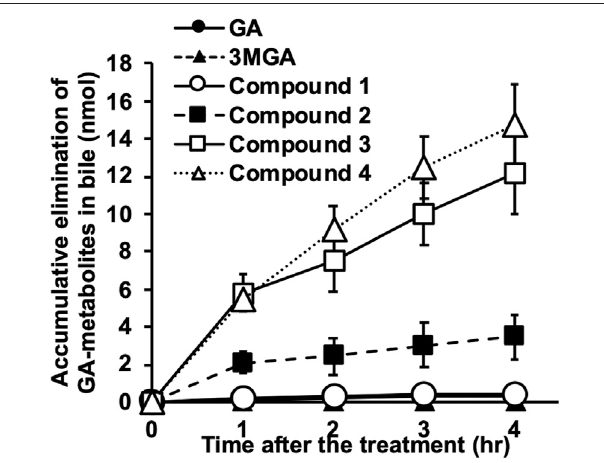
FIGURE 6 | Elimination of glycyrrhizin (GL) metabolites into bile in Sprague-Dawley (SD) rats. Female SD rats (10 week-old) were anesthetized using intraperitoneal injection of urethane (1 g/kg), and biliary tracts were cannulated. Glycyrrhetinic acid (GA, 0.2 mg/kg) was injected into jugular veins and bile was collected every hour for 4 h. Concentrations of GA metabolites were measured using liquid chromatography-tandem mass spectrometry (LC-MS/MS) and accumulated elimination of GA-metabolites are means ± standard error (S.E: n (cid:2) 3).